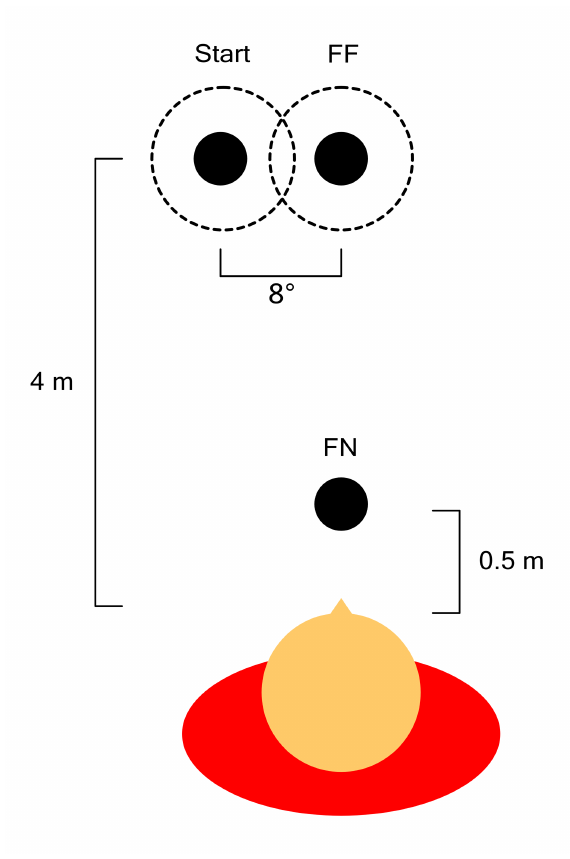
Figure 1. Schematic overview of experiment 1. Participants first fixated the target at a far location offset by 8° to the left (shown) or right. The target then either moved to another far position (FF) or a near position (FN), both at 0° azimuth. In half of the trials the size of the target was corrected to its distance from the participant so that it always occupied an equal area of the visual field (dotted